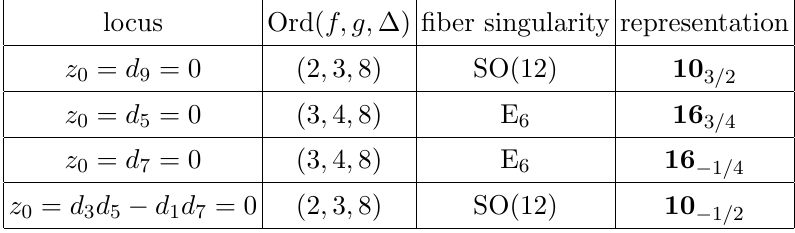
Table 6 . Codimension-two loci, enhanced symmetry groups and matter